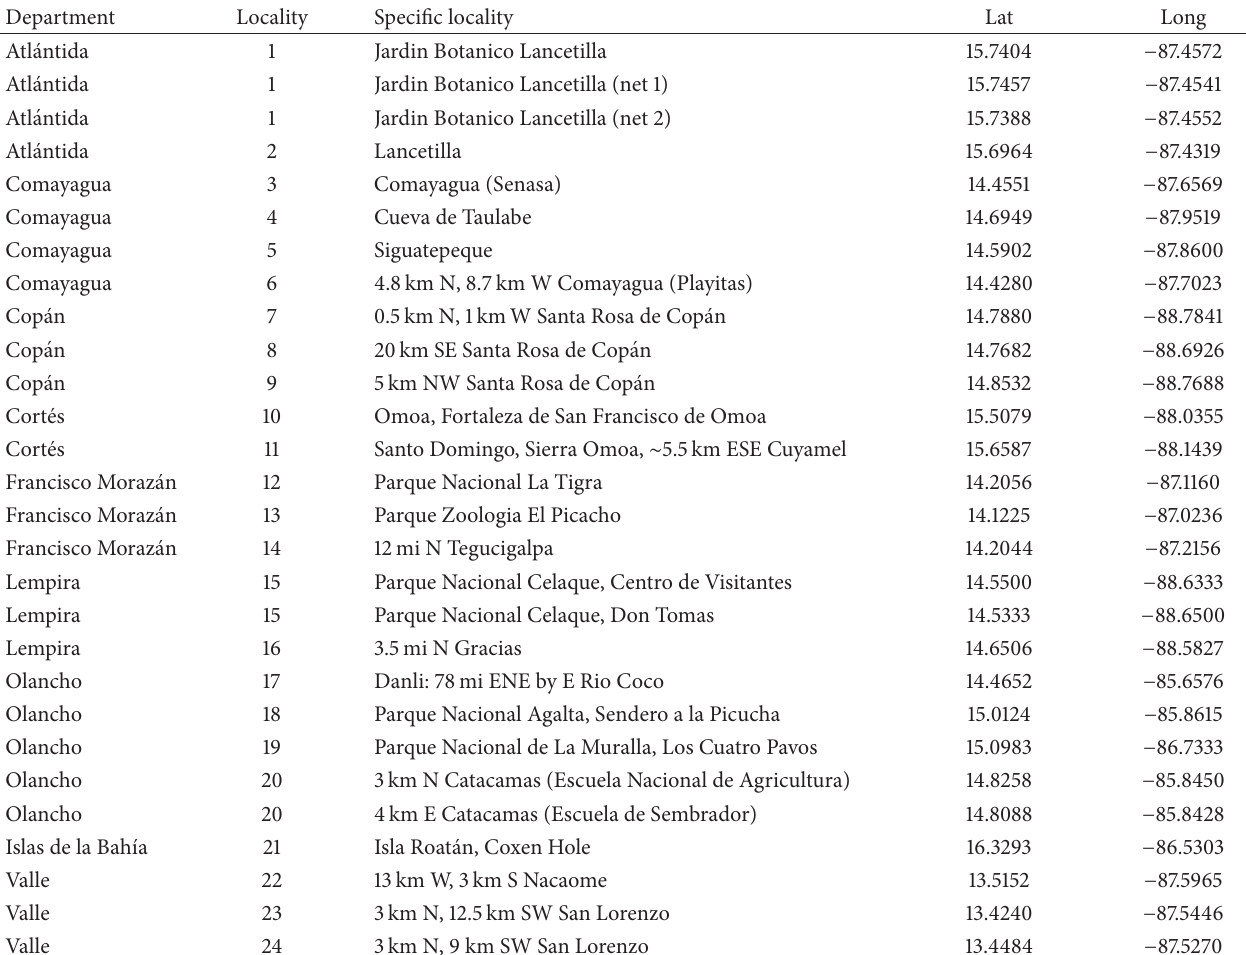
Table 1: Gazetteer of Honduran bat fly collection localities. Locality numbers correspond to map (Figure 1). Latitude and longitude are in decimal degrees. Specific localities with identical locality numbers are close in proximity, not warranting separate placement on the map (Figure